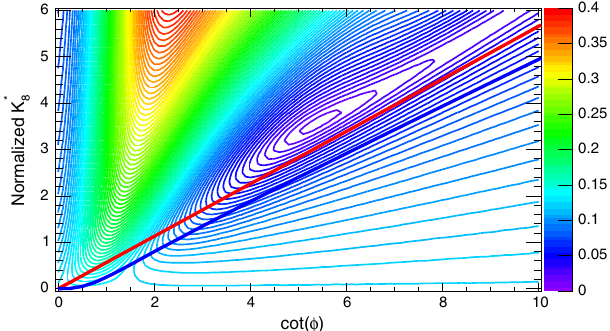
FIG. 3. Uniformity of the intensity in the beam position region within (cid:5) 1 σ shown as a function of normalized K (cid:1) 8 and cot ϕ . The t solid blue and red lines are given by the filament model approximation by Eqs. (12) and (14), respectively.